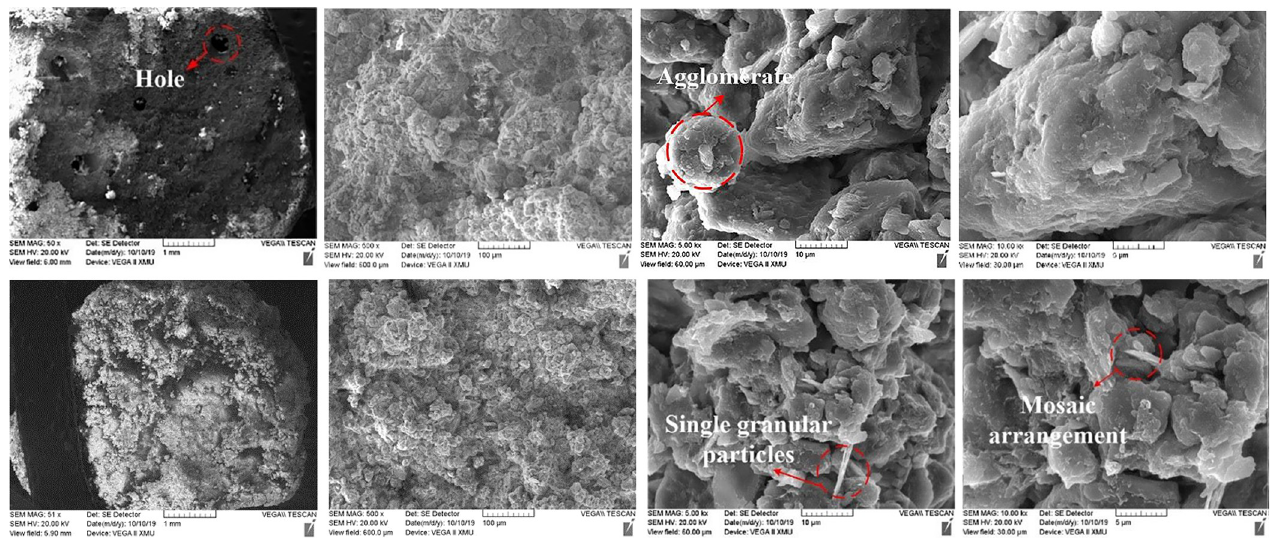
Fig 19. SEM image of undisturbed & remolded loess. https://doi.org/10.1371/journal.pone.0263676.g019 ring knife specimens (diameter of about 20 mm and height of about 61.8 mm). The three-view (overlooking, left-view and main-view) and three-dimensional reconstruction of the specimen are shown in Fig 20A and 20B. It can be seen that the undisturbed loess shows obvious cracks and pores, and the number of large pores is relatively large. The remolded loess specimens are dense without obvious cracks and large pores [53]. For undisturbed and remolded loess specimens, the shear strength of loess-steel interface mainly comes from the friction between steel interface and loess specimen particles and the friction between loess specimen particles. When the steel friction plate rotates and shears, the loess particles bite each other, and the force chain formed transfers the external load. Due to the obvious edge angle of undisturbed loess particles, the friction between particles and that between steel interface and particles are larger. However, the shape of disturbed particles of remolded loess is close to muddy circle, therefore, the interlocking friction between particles is small, and the sliding effect between steel interface and itself increases. In addition, the cement between the undisturbed loess particles provides the particles with strong cementation, and